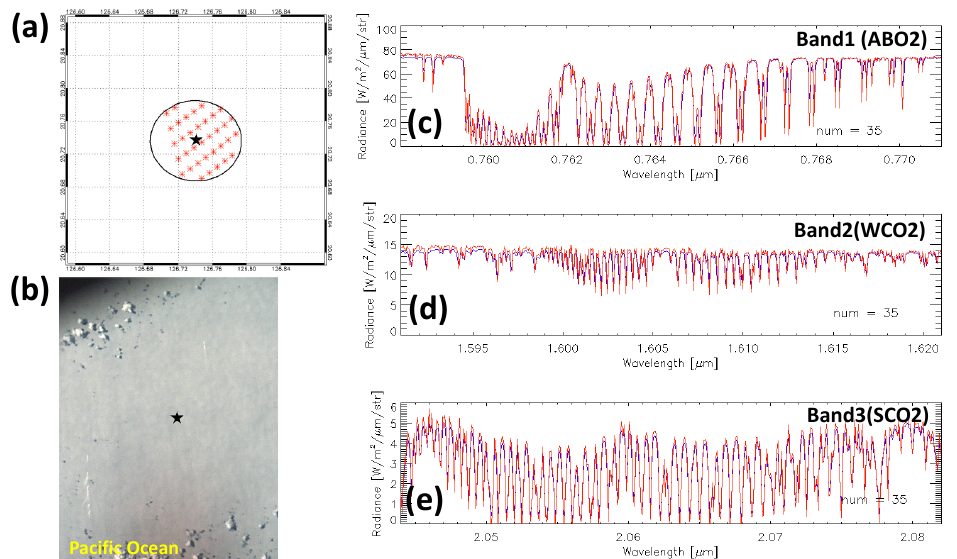
Figure A1. The spectral comparison between glint GOSAT and glint OCO-2 over the Pacific Ocean at 20.74° N, 126.74° E on 25 June 2015 with the GOSAT high gain. ( a ) The GOSAT footprint and OCO-2 matched-up pixels; the black line, the black star and the red dots represent the GOSAT IFOV, the center of the GOSAT IFOV and the OCO-2 observation points within GOSAT IFOV, respectively; ( b ) The GOSAT camera image from CAM bore sighted with TANSO-FTS. The spectral comparison of ( c ) ABO2; ( d ) WCO2 and ( e ) SCO2 bands. Red and blue lines represent the GOSAT and OCO-2 spectral radiances, respectively.